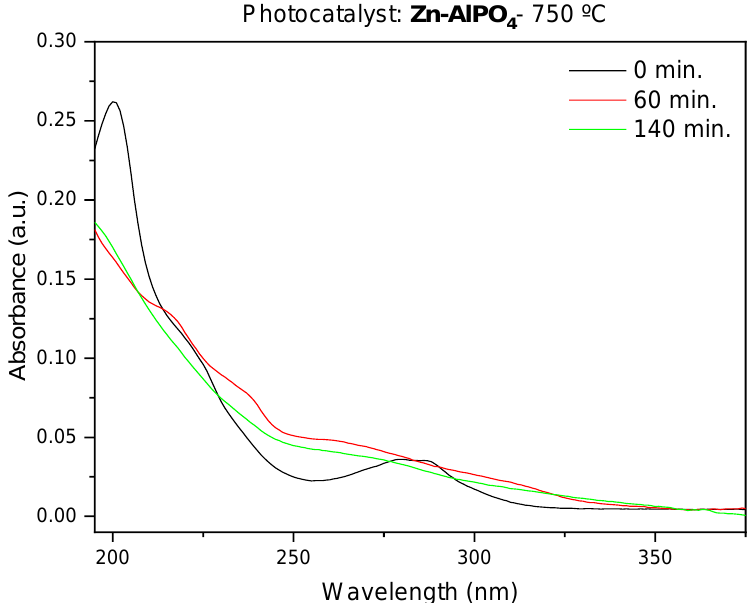
Figure 13. Absorption spectra of fipronil (Ci = 2880 µg L −1 ) in the presence of Zn-AlPO 4 (103 mg) heat-treated at 750 °C, under magnetic stirring and UV radiation.